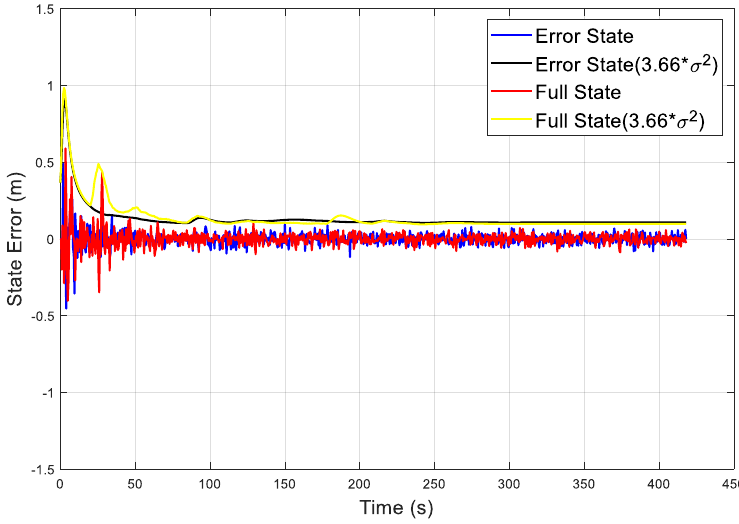
Figure 9. The state error of the error-state and full-state EKFs.